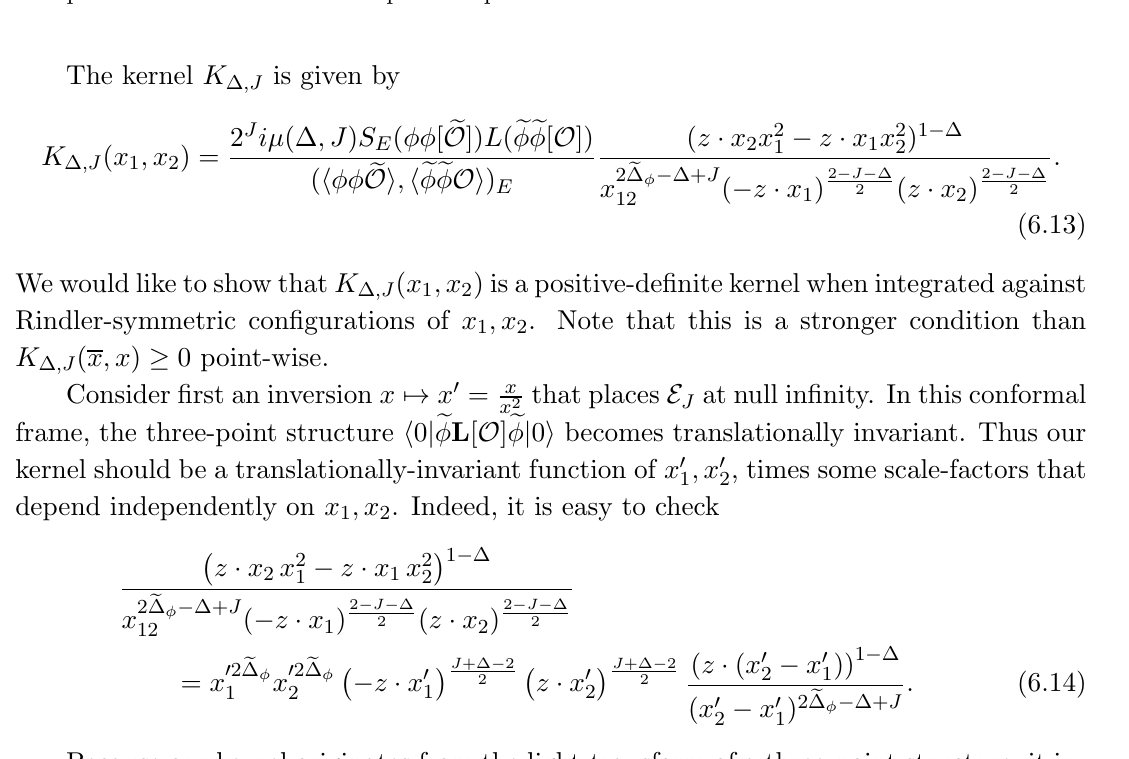
(the principal series) and 2